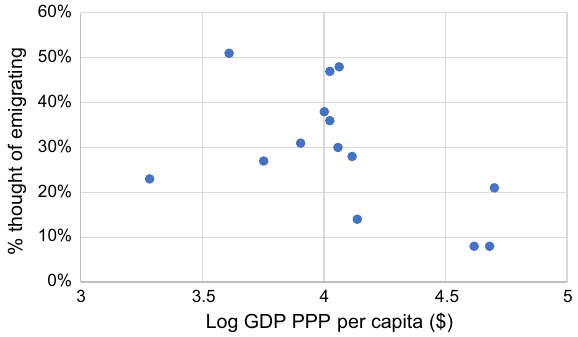
Fig. 6 Inverse U-curve relationship between the emigration desire and development (see Table 1 for